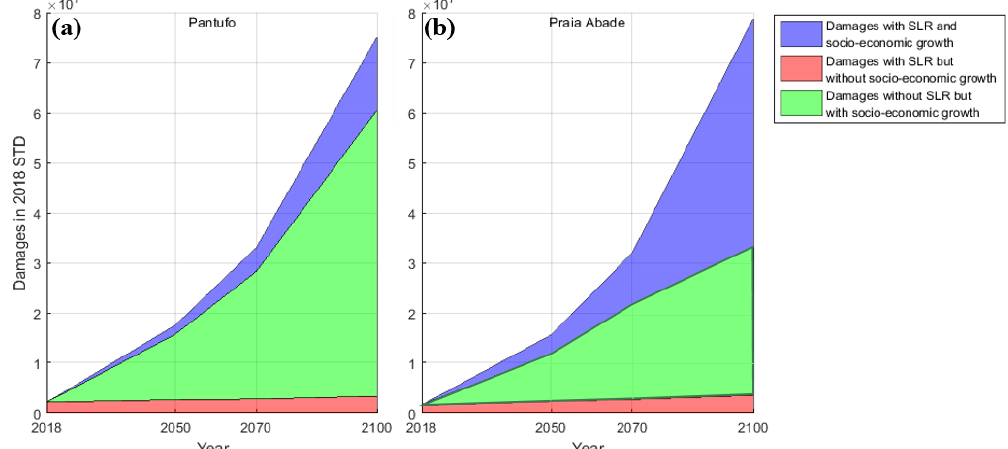
Figure 10. The relevance of socioeconomic changes. (a) Damages under the baseline scenario expressed in São Toméan dobras (STD) for Pantufo and (b) Praia Abade over time, differentiated by contributing factors: damages driven only by climate-change-induced SLR (red), damages driven only by socioeconomic changes (green) and damages driven by both (blue).